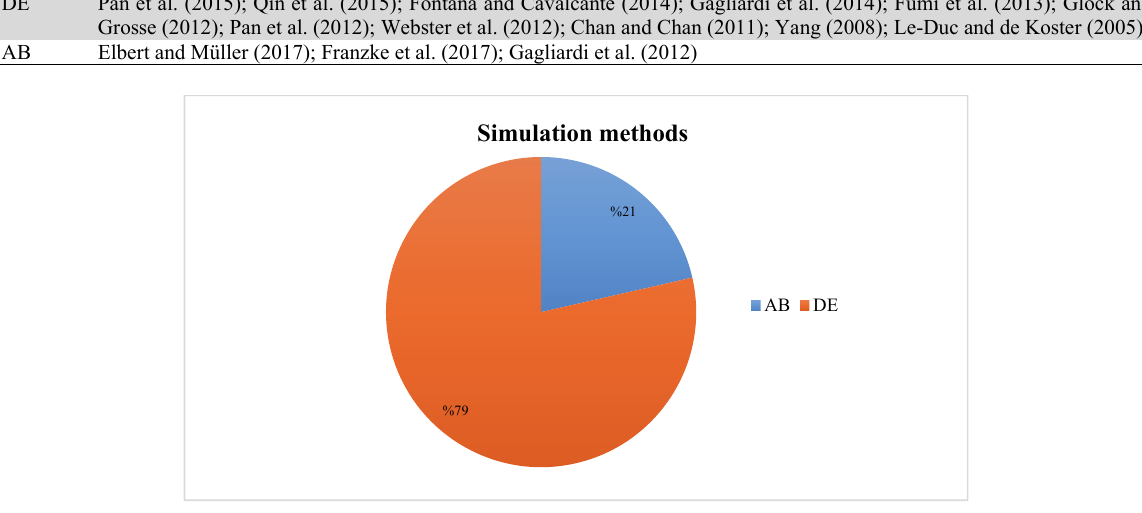
Fig. 10. Distribution of simulation